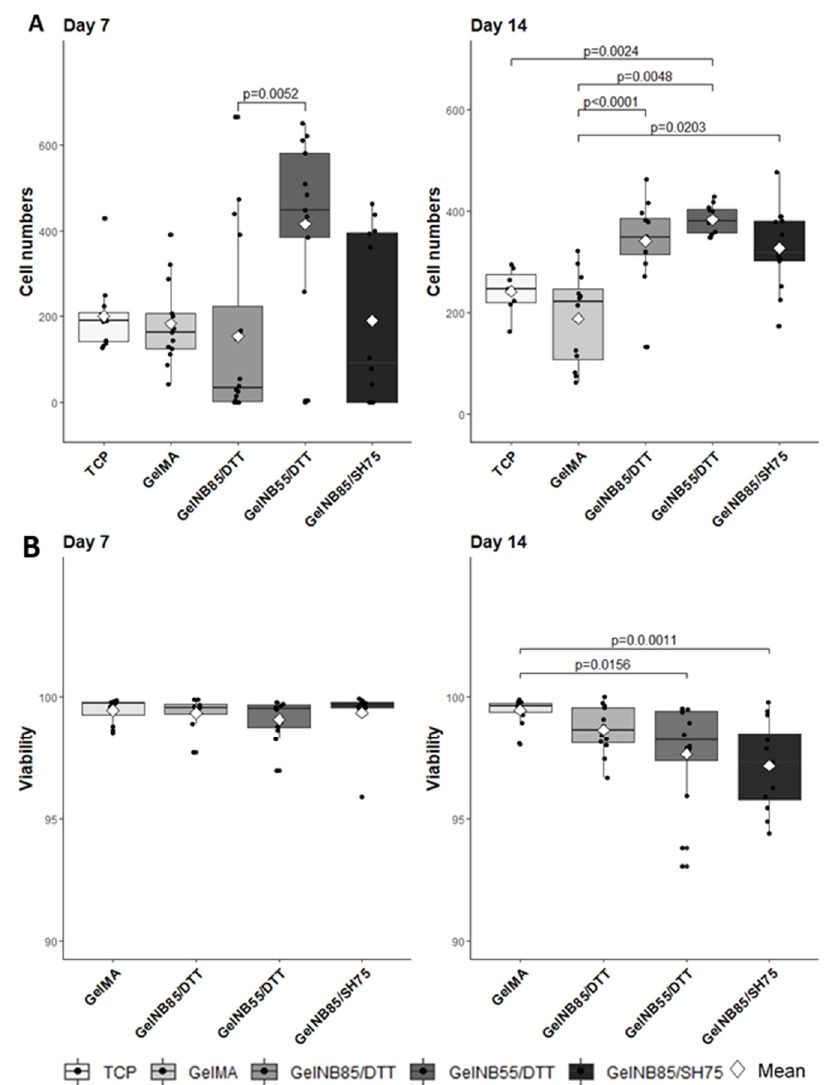
Figure 5. Tenocyte characteristics as determined on thiol-ene based hydrogels and compared to both TCP and gel-MA: ( A ) cell proliferation: cell numbers per image are shown, ( B ) viability assay: the percentage of the area occupied by living cells is shown in relation to the total cell area cul- tured per image. Significant differences are shown with adjusted p-values. After 14 days in culture the number of cells on all thiol-ene based hydrogels were comparable and significantly higher than on gel-MA. It can therefore be concluded that gel-MA is not optimal to support tenocyte cultures. Gel-NB55/DTT also significantly differed from TCP which indicates superior biocompatibility of gel-NB55/DTT. Viability on all hydrogels exceeded 95%, indicating excellent biocompatibil- ity (>70%, ISO 10993-5 (2009)). The decreased viability on gel-NB55/DTT can be explained by con-